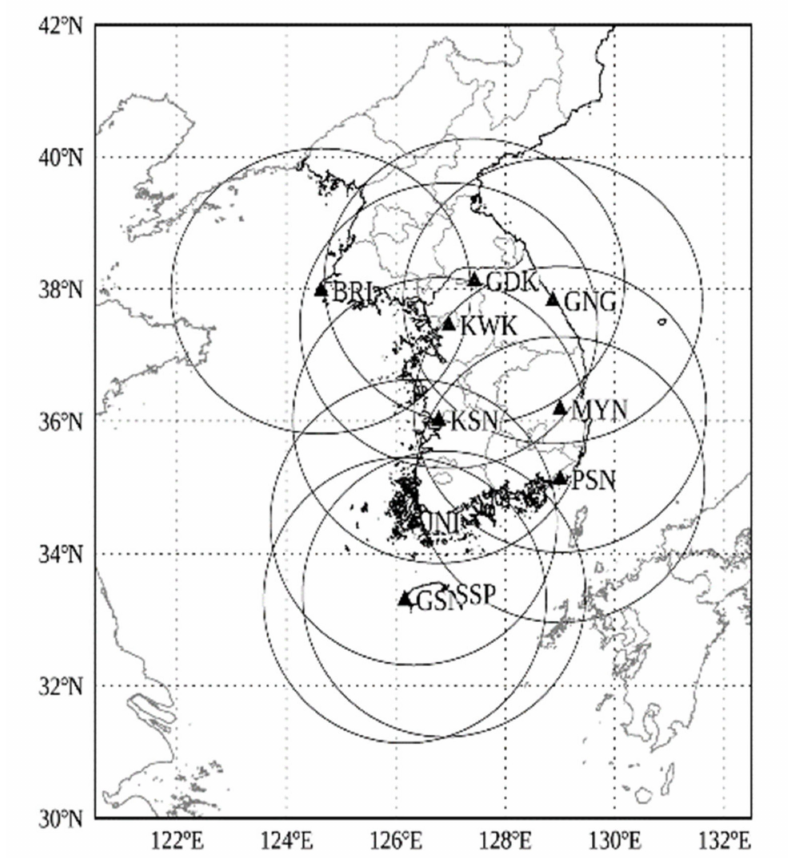
Figure 1. Deployment of KMA’s S-band dual-polarization weather radar network. The ten circles indicate the 240 km radius coverage of each radar within the KMA